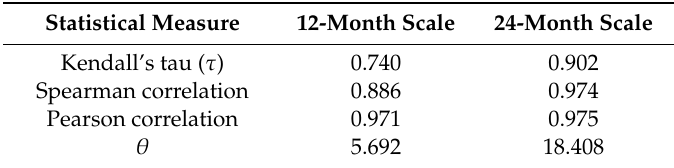
Table 4. Correlations between drought severity and duration and corresponding θ calculated from Equation